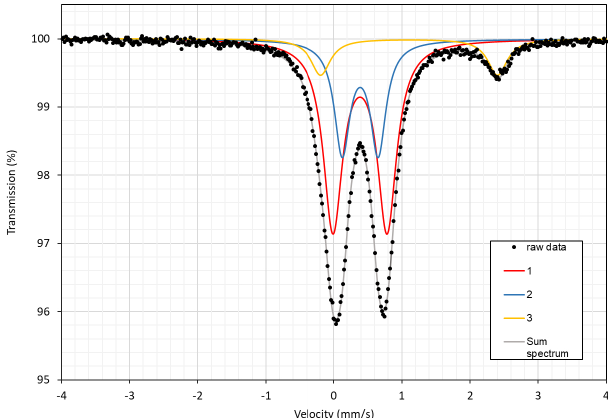
Figure 8. Transmission 57 Fe Mössbauer spectrum of